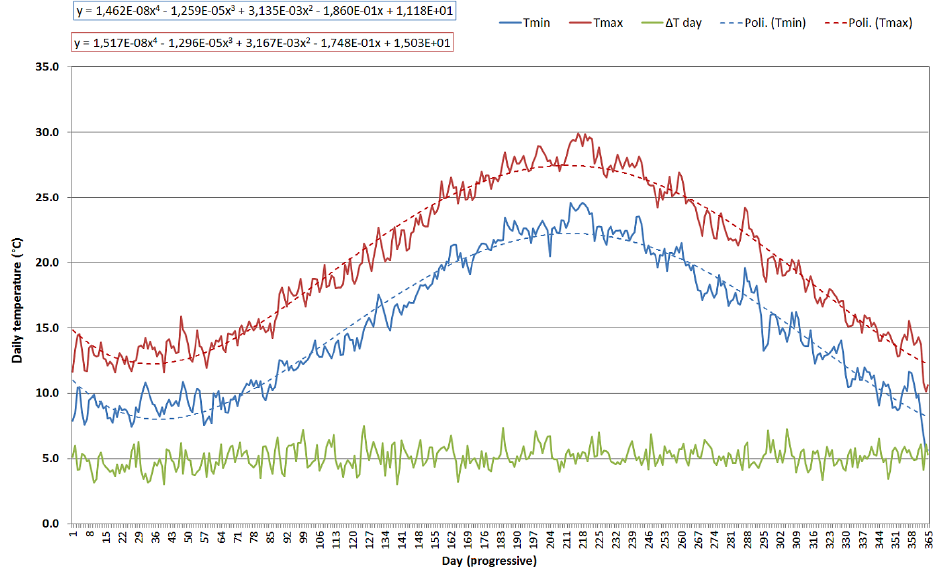
Figure 14. Average daily thermal trend, for 2014–2018, recorded by Denza weather station with fourth-grade polynomial equations. Maxi- mum temperature values are indicated with a red line, minimum values with a blue line and daily temperature range with a green